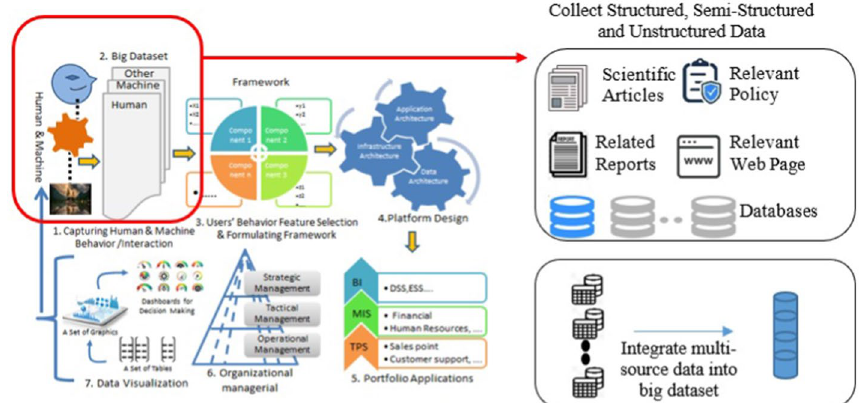
Fig. 2 General research framework (modified from